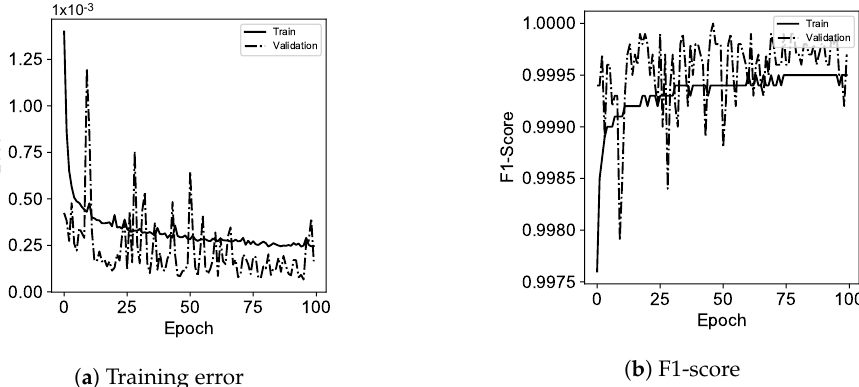
Figure 6. The loss and F1-score over 100 epochs for the RNN server management.